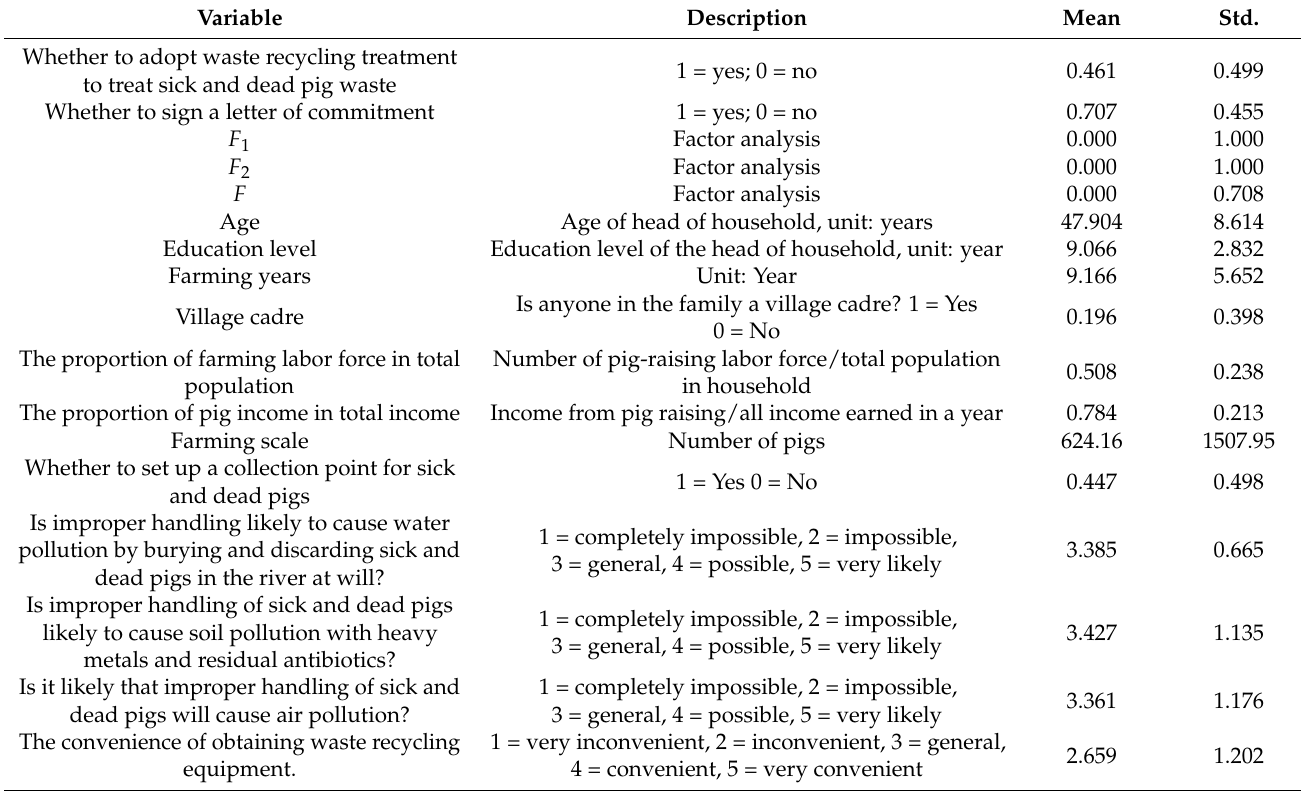
Table 3. Descriptive statistical